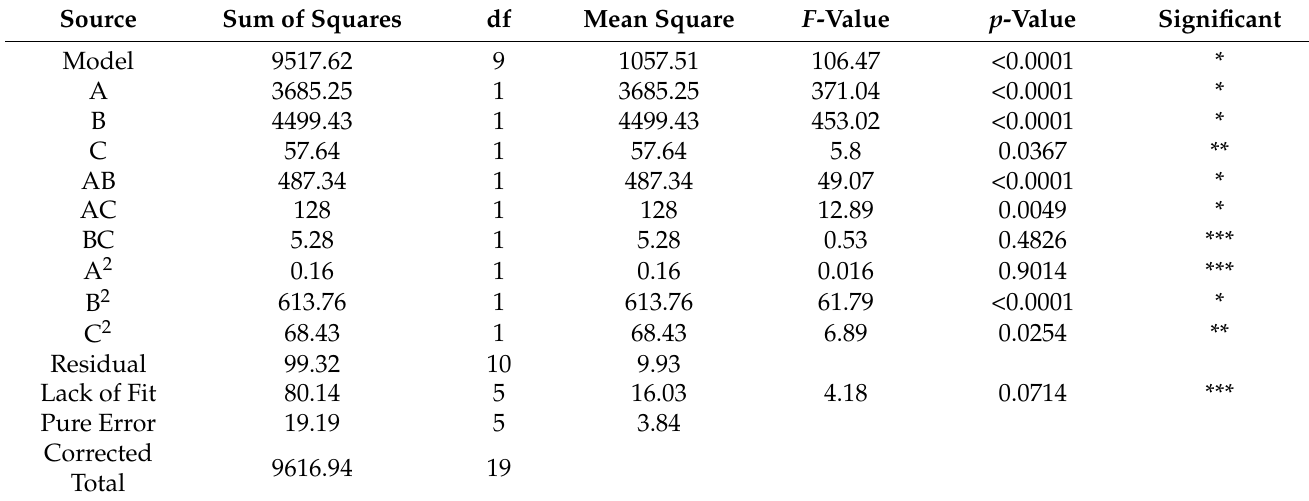
Table 2. ANOVA results for quadratic model developed for Hydroxyl value of MOG-polyol.